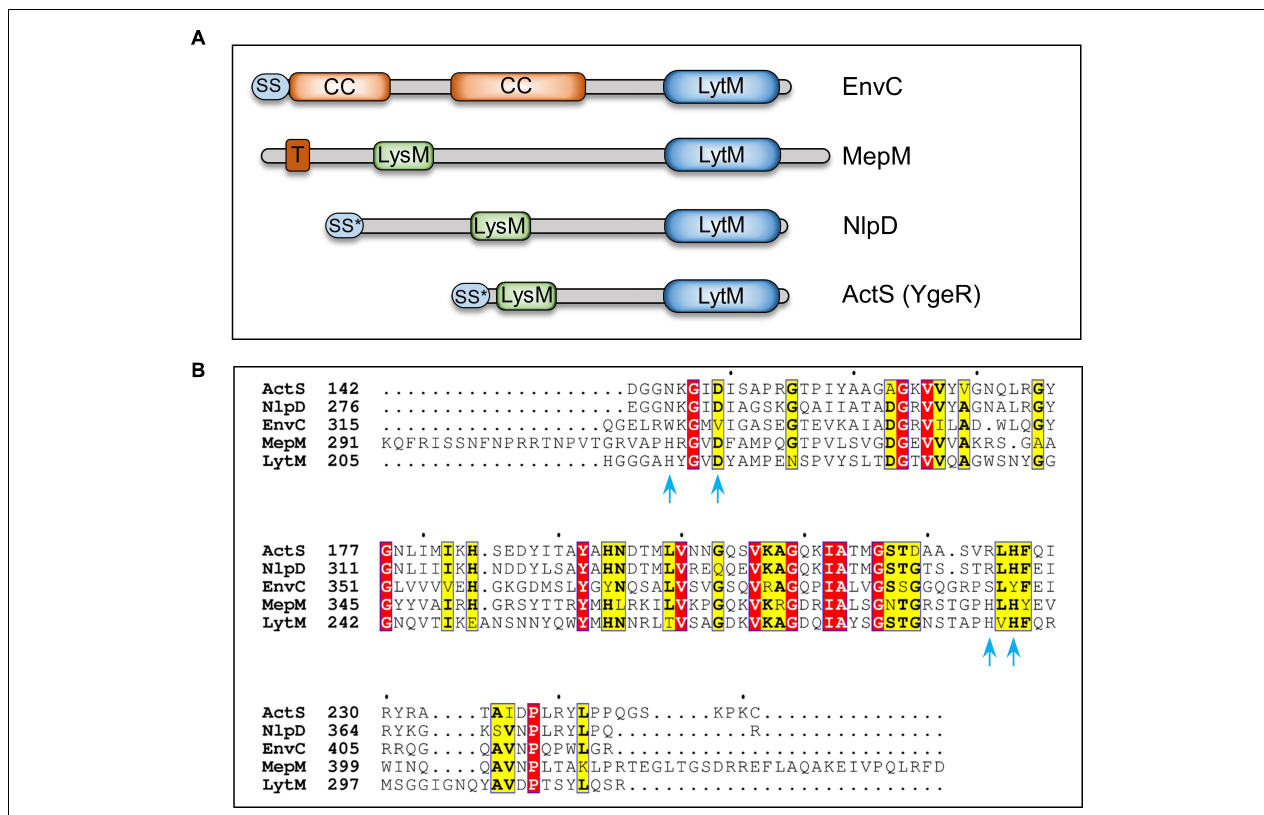
FIGURE 1 | Domain organization and sequence alignment of LytM-domain factors. (A) Domain architecture of LytM factors (EnvC, MepM, NlpD, and ActS) of Escherichia coli . (B) Sequence alignment of C-terminal domains of LytM, EnvC, NlpD, MepM, and ActS using T-Coffee and ESPript programs (Di Tommaso et al., 2011, http://espript.ibcp.fr). LytM is a glycyl-glycine endopeptidase that cleaves peptidoglycan of Staphylococcus aureus . Amino acid residues of LytM involved in Zinc binding and catalysis (Firczuk et al., 2005) are indicated with blue arrows. Red and yellow boxes highlight the identities and similarities, respectively.